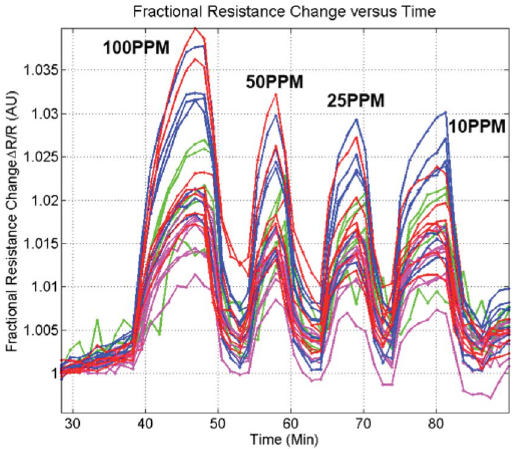
Figure 5. Concentration dependence of assembled sensors to ammonia vapor of varying